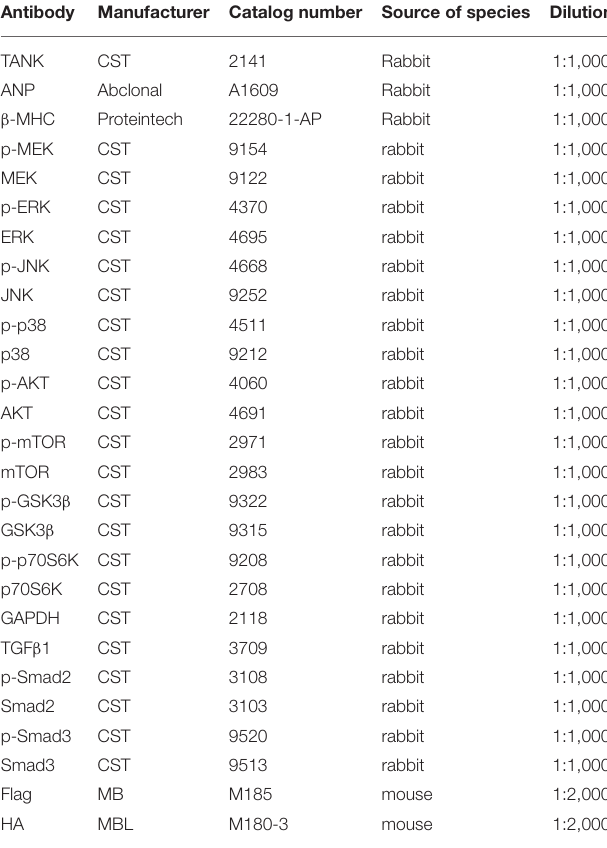
TABLE 1 | Information of reagents used in